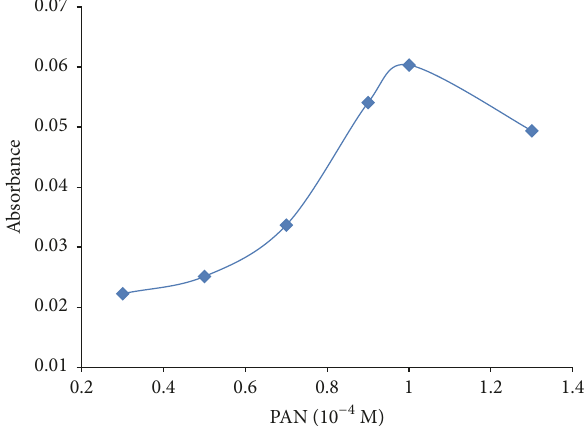
Figure 5: The effect of 1-(2-pyridylazo)-2-naphthol concentration on absorbance of lead with SFODME. Extraction circumstances: Pb: 10 𝜇 gL −1 ; pH: 9; extraction solvent, 1-undecanol (100 𝜇 L); sample volume, 10 mL; dispersive solvent, acetonitrile (200 𝜇 L); chelating reagent [PAN], 1 × 10 −4 molL −1 .